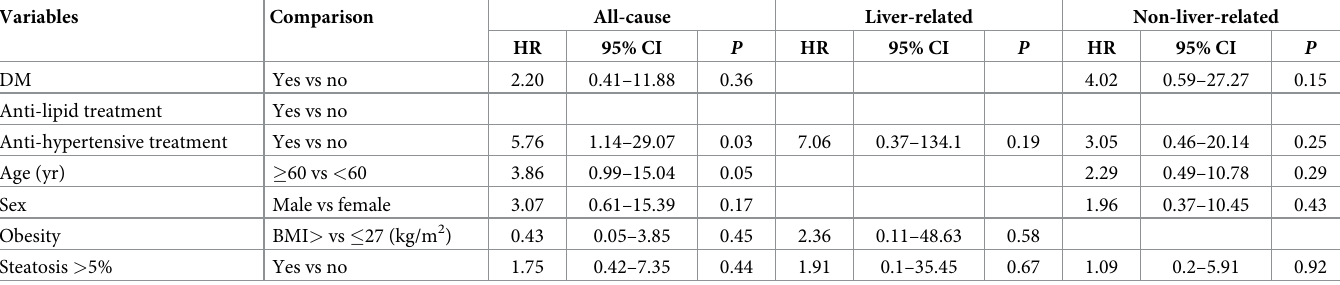
Table 9. Features Associated With Mortality In Mild Fibrotic Patients (fibrosis score 0–2) with SVR (N = 686) According to Cox Proportional Hazards Model: Results of Multivariate Analyses.